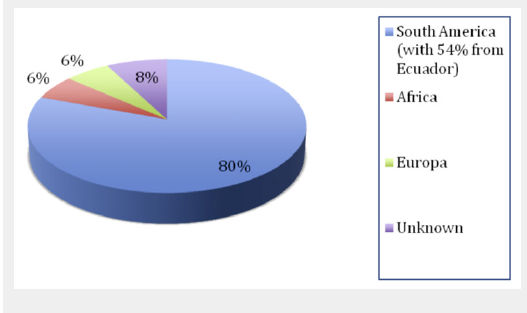
Native country of patients.